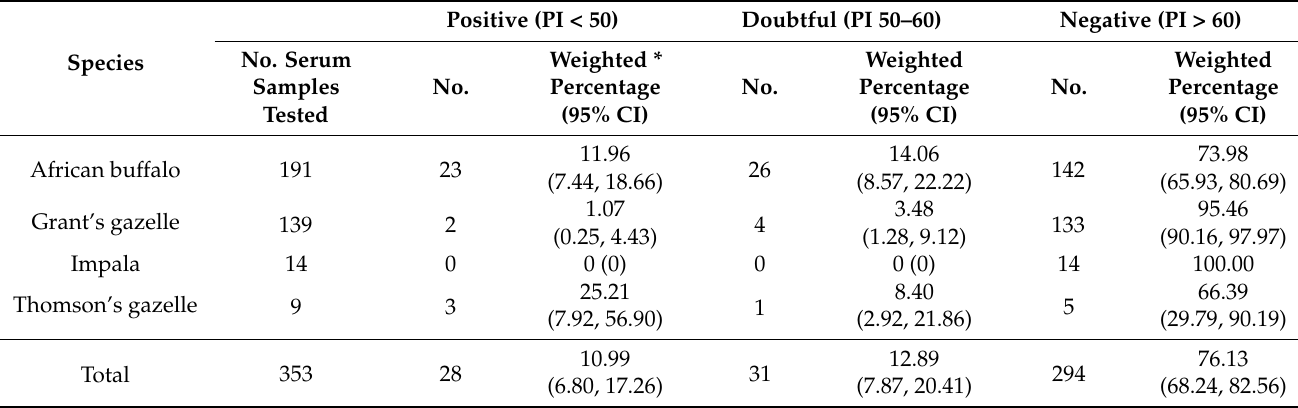
Table 3. Results of peste des petits ruminants virus (PPRV) competitive enzyme-linked immunosorbent assay (cELISA) of wild animal serum samples by species during the cross-sectional survey in the Greater Serengeti ecosystem, 2018–2019. Positive (PI < 50) Doubtful (PI 50–60) Negative (PI > 60) No. Serum Species